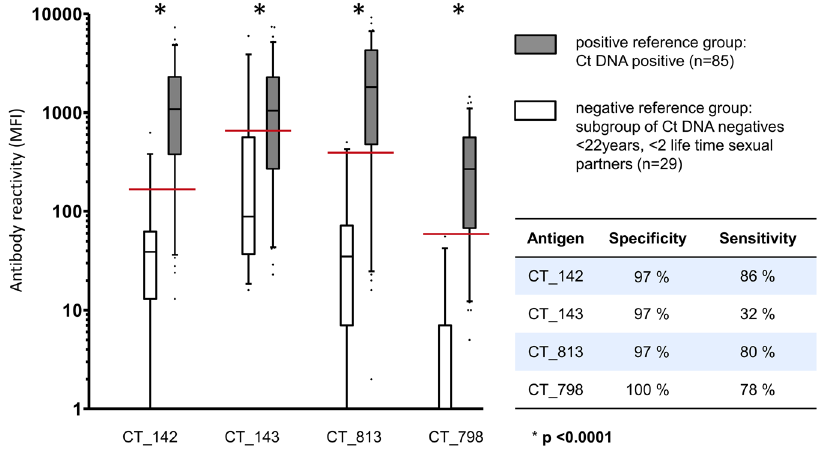
Figure 6. Performance of de novo identified antigens in multiplex serology. Two Ct infection reference groups (grey, positive, and white, negative) were analyzed with four antigens representing possible new serological Ct infection markers. On the y-axis, MFI are plotted on a logarithmic scale, and distribution of reactivities for each group and antigen is displayed as box plot. Cut-off values were determined by Receiver Operating Characteristic (ROC) analysis and are shown as red lines resulting in specificity and sensitivity estimates shown in the inserted table.